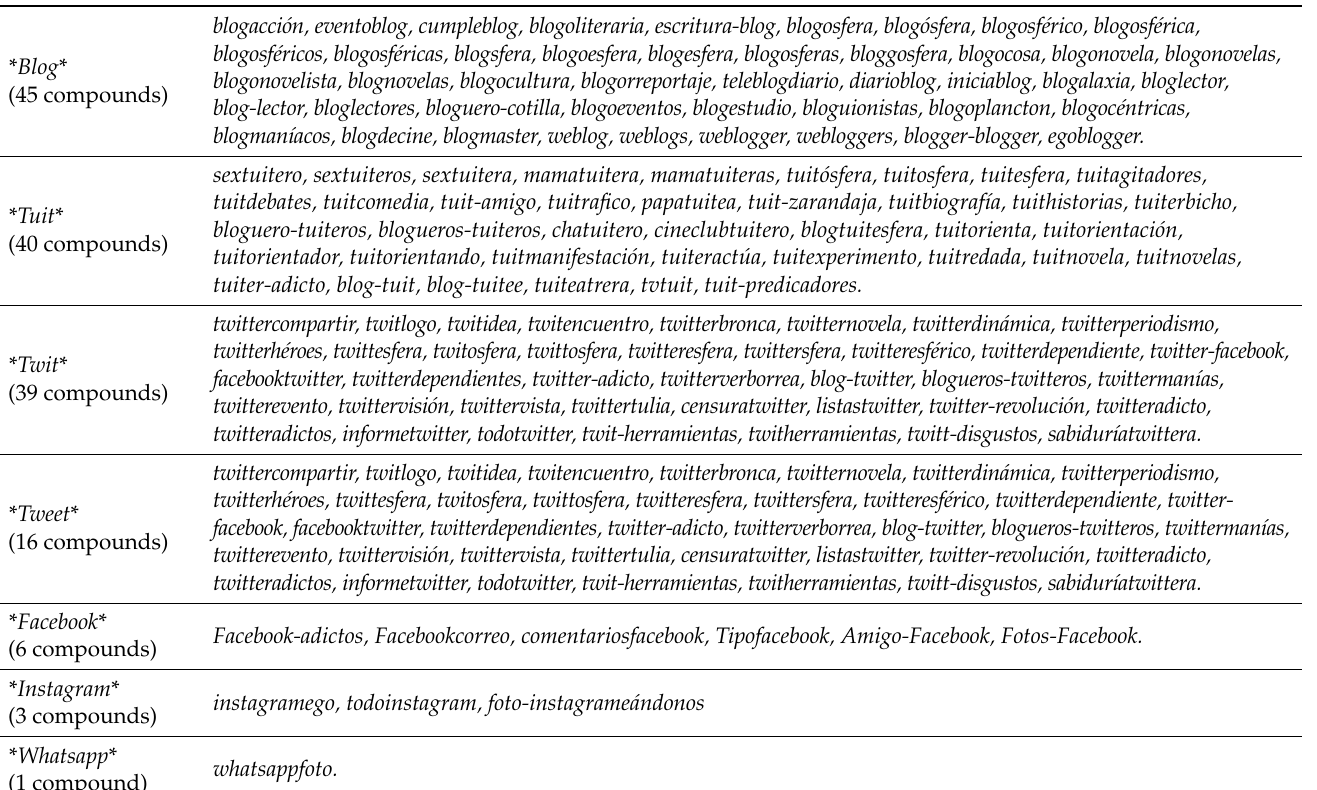
Table 4. Compounds attested in our corpus-based